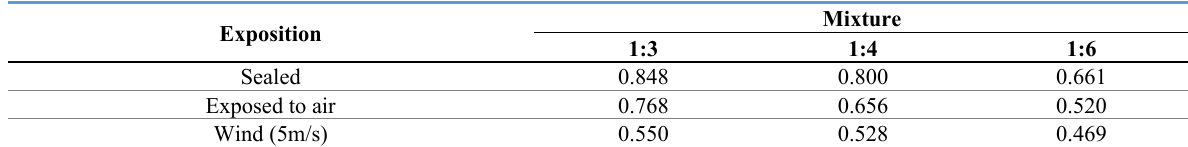
Table 5. Comparison of the magnitude of average long-term maximum shrinkage for the different exposures adopted (mm/m)